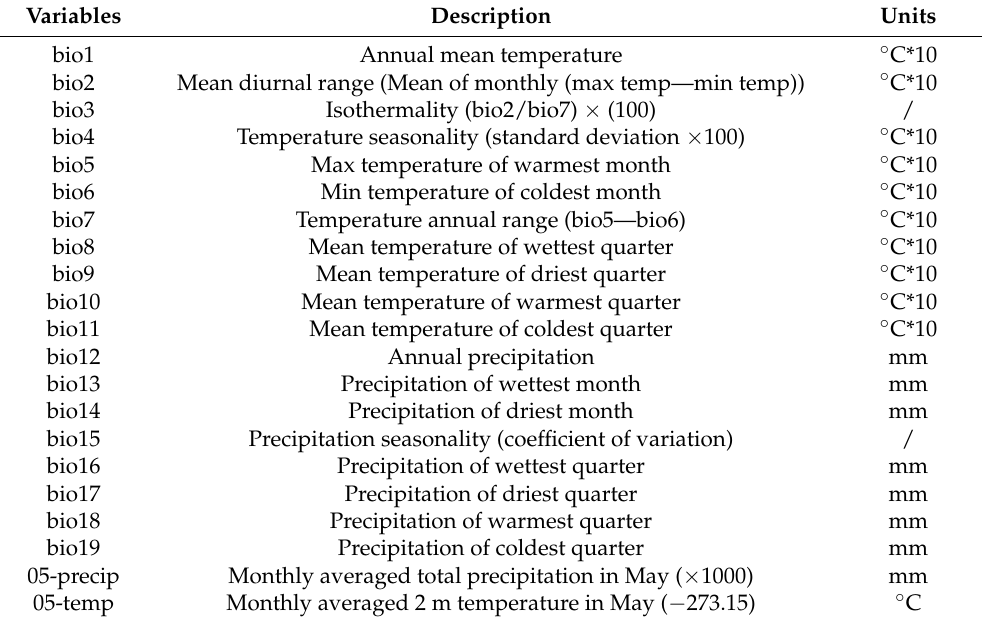
Table 2. Climatic